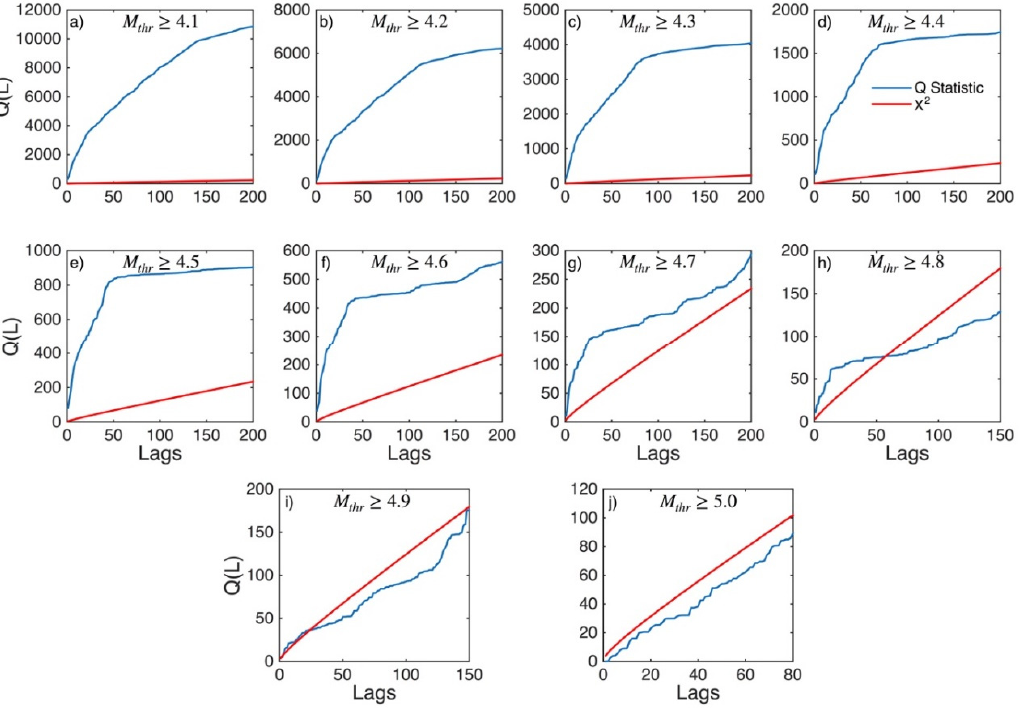
Figure A8. PACF values (orange stems) and their 95% confidence intervals (blue lines) for Eastern Hellenic Arc (sub − area 4) for magnitude thresholds ( M thr ) varying from 4.1 to 5.0 (subplots a – j ).